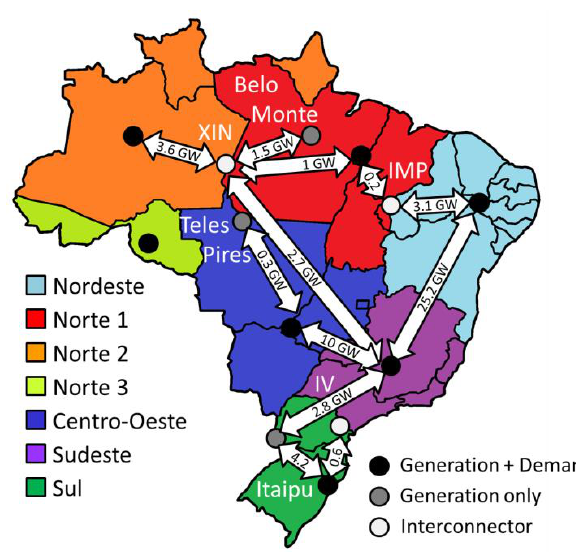
Figure 7. Model endogenous grid capacity expansion in scenario Base in GW. Values for the other scenarios are similar and summarized in Table S10.